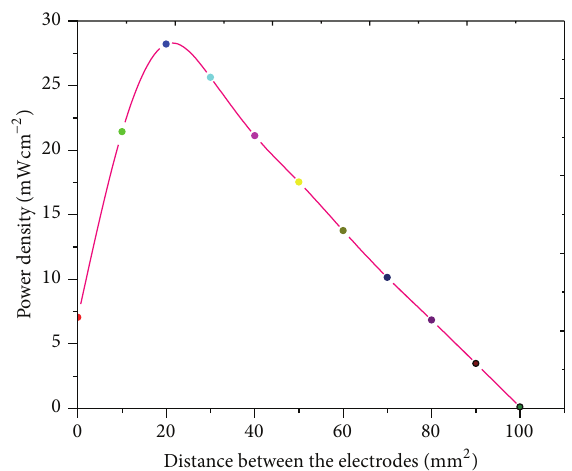
Figure 8: Effect of distance between anode and cathode on the maximum power density of the MLSPBFC at room